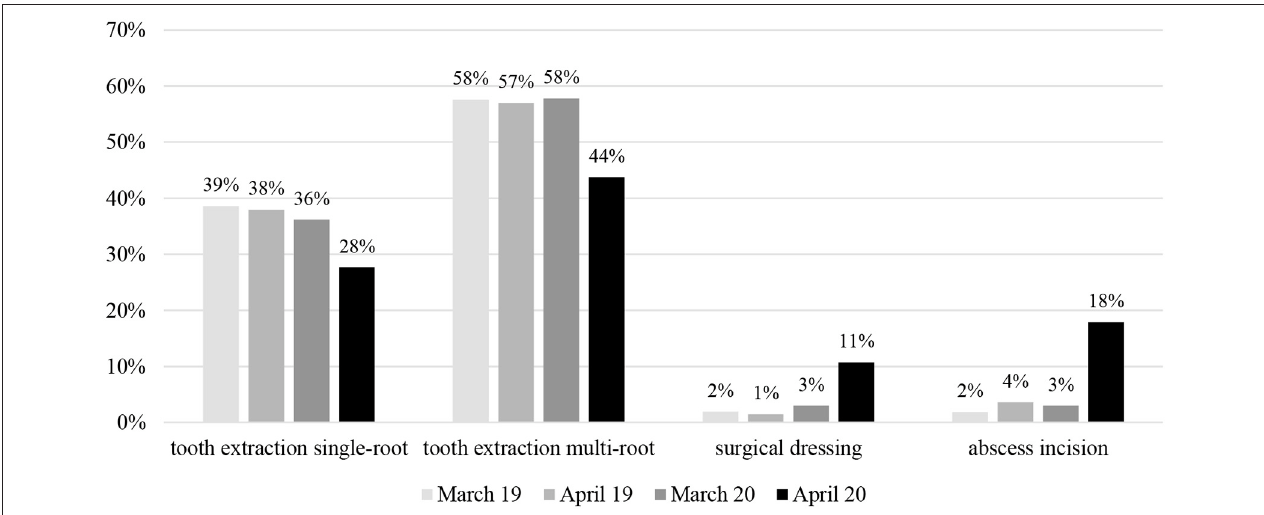
FIGURE 1 | The Statistical comparison showing the percentage of the dental service procedures for surgical procedures (primary and secondary dentition) conducted in March and April 2019 and 2020 y.